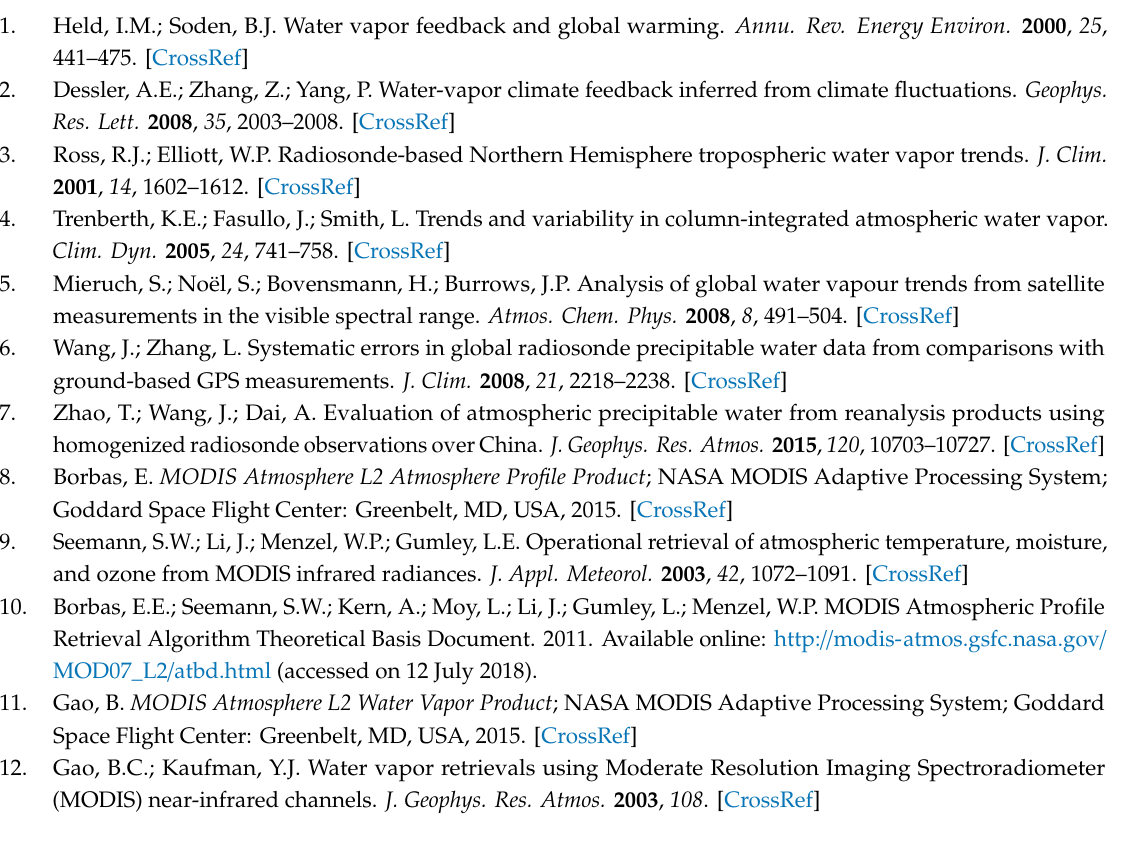
Figure S1. Same as Figure 3, but zooming into the North America and Europe regions, Figure S2: Biases between MODIS and IGS PW along with latitudinal bins, Figure S3: Monthly di ff erences of (a) MODIS IR and (b) MODIS NIR with IGS PW, averaged over all GPS stations for 2000–2014, and (c) case for large bias of POVE station in Brazil, Figure S4: Linear trends of (a) MERRA PW, (b) MODIS IR PW, and (c) MODIS NIR PW over land at 60 ◦ S–60 ◦ N, Figure S5: Di ff erences of monthly PW between MODIS IR and MODIS NIR with MERRA for grid-box area in Figure